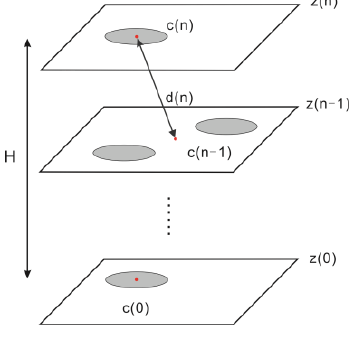
Figure 14. Centroid path of tortuosity module. The illustration of Avizo Tortuosity Module: first it computes c ( i ) of each slices z ( i ) of the image, then it computes the path length through l = ∑ d ( i ) and eventually divides it by the number of slices H = z(n) z(0) along z-axis.